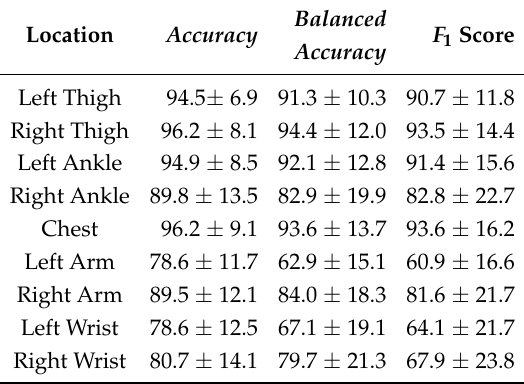
Table 2. Performance (%) of the ensemble tree classification in lying-posture detection for nine different body locations on the Class-Act dataset using leave-one-subject-out (LOSO)